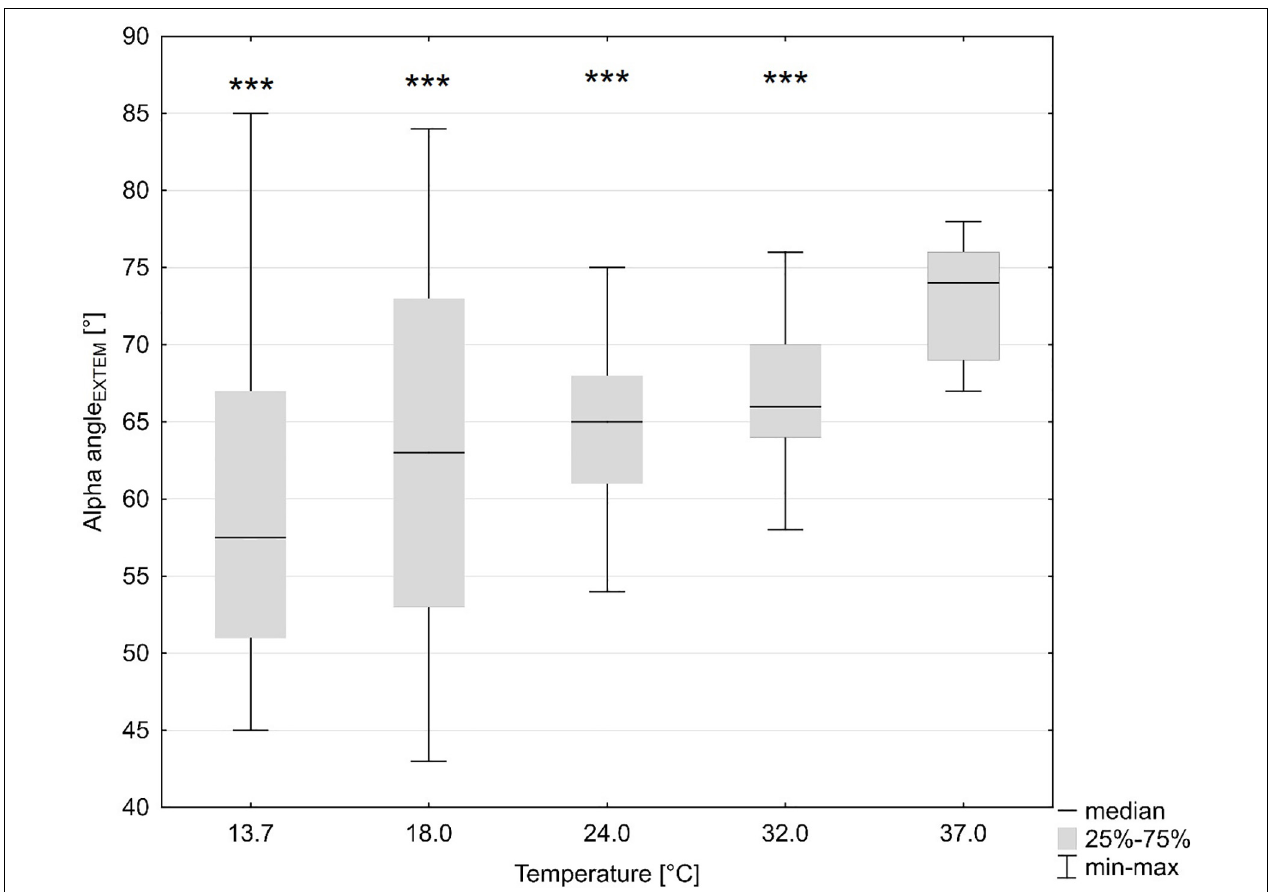
FIGURE 1 | Influence of temperature (x axis, temperature in degrees Celsius) on global coagulation (y axis, alpha angle in ExTEM in degrees). *** p < 0.001 for significant differences as assessed with repeated measures ANOVA as compared to baseline (37 ◦ C).